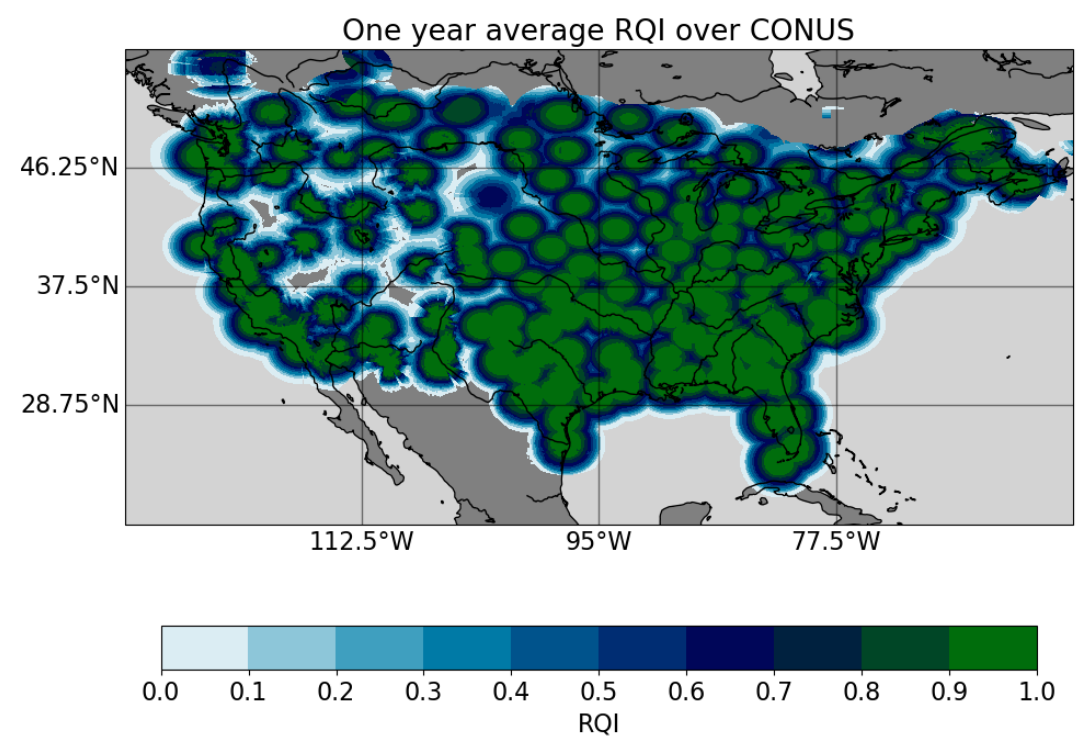
Figure 1. One-year average MRMS Radar Quality Index at 15 km resolution over